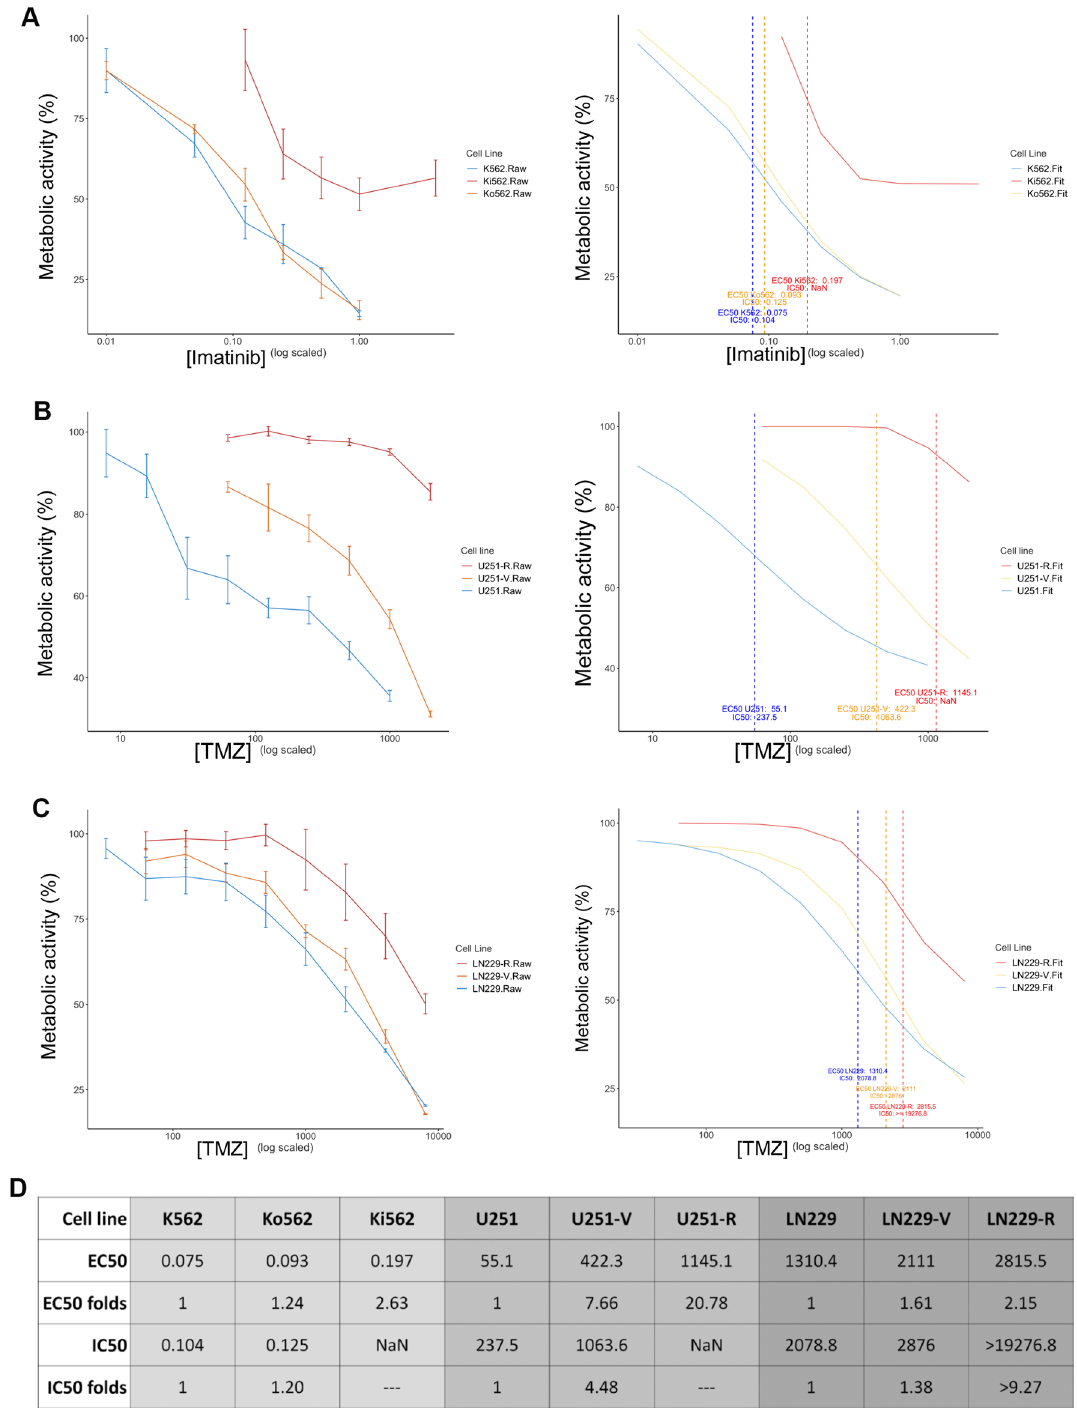
Figure 2. Effect of first-line drugs on metabolic activity. The different cell lines were treated with ( A ) RPMI-C or Imatinib (K562, Ko562, and Ki562), ( B ) DMEM-C or TMZ (U251, U251-V, and U251-R) or ( C ) DMEM-C or TMZ (LN229, LN229-V, and LN229-R) for 48 h (CML cells) or 72 h (GBM cells) and metabolic activity were evaluated by XTT assay. Left panel shows Raw data while right panel shows Fit data. ( D ) Comparison of the IC50 and EC50 obtained to each model. NaN stands for not a number, and the meaning is that the curve did not reach the 50% inhibition needed to compute de